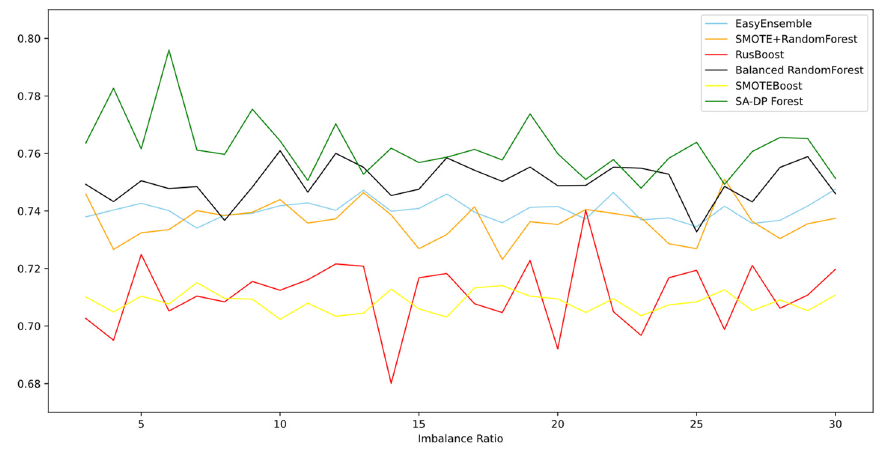
Figure 4. AUC according to different imbalance ratios (German credit).